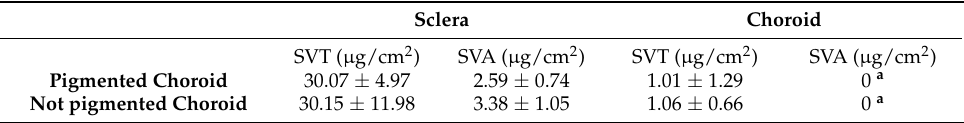
Table 4. SVT and SVA retained in Sclera and Choroid after 48 h from TN SVT